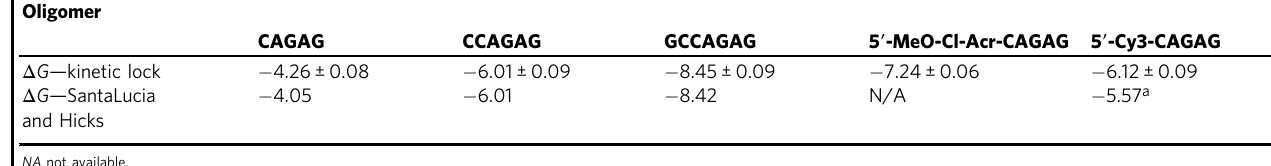
Table 1 Comparison of the experimental binding energies (in kcal mol − 1 ) obtained by kinetic locking with standard predictions by the nearest-neighbor model at 25